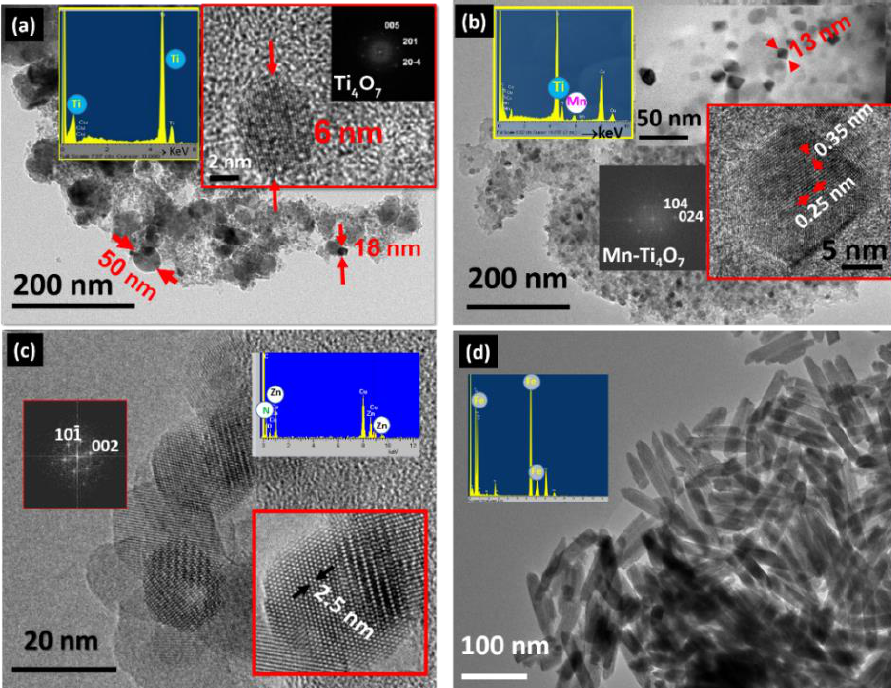
Figure 4. Characteristic low- and medium-magnification TEM images together with the typical EDS spectra of TiO 2 reduced NPs ( a ); ( b ) Mn-doped TiO 2 -reduced NPs; ( c ) ZnO-functionalized NPs; ( d ) β -FeOOH nanowires.